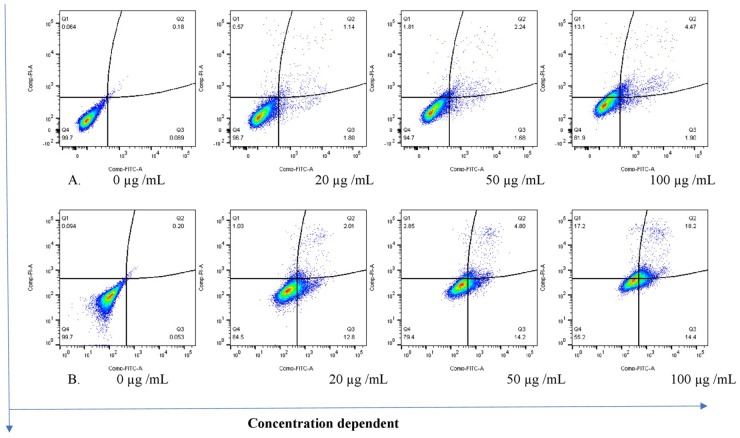
Stained cells and crude extract of C. triflora induces apoptosis of THP-1 cells post (A) 24h and (B) 48 h of treatment. Q1: necrotic cells (annexin V-/PI+); Q2: late apoptosis (annexin V+/PI+); Q3: apoptotic cells; (annexin V+/PI-) Q4: live cell (annexin V-/PI-).